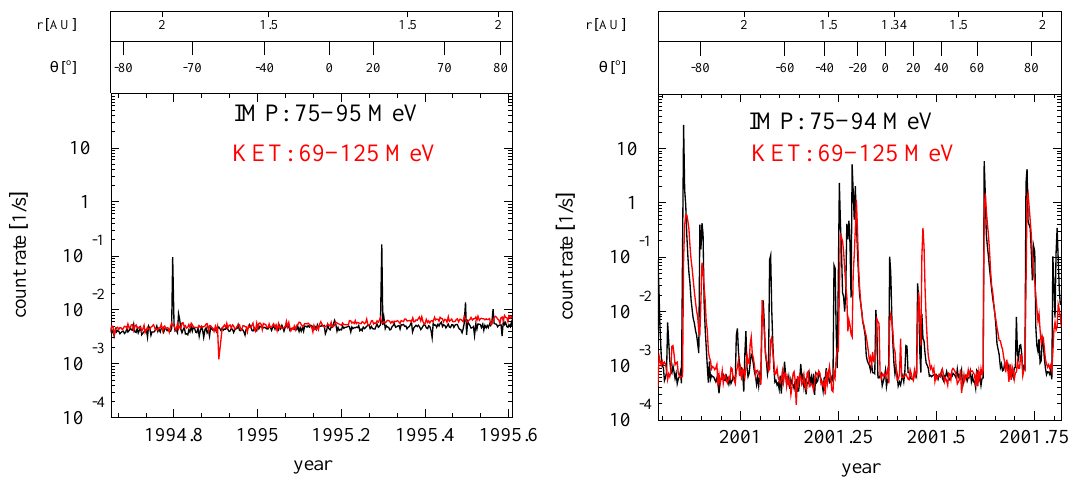
Fig. 6. Daily averaged time profiles of 75–95 MeV and 75–125 MeV protons at Earth and Ulysses for the first and second latitude scan.